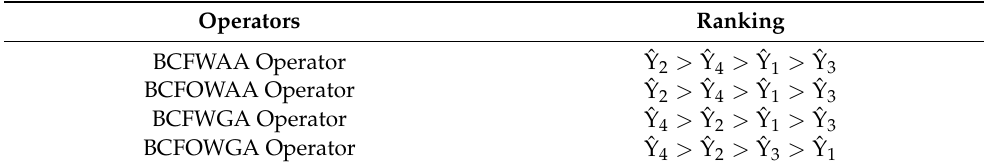
Table 4. Ranking values.